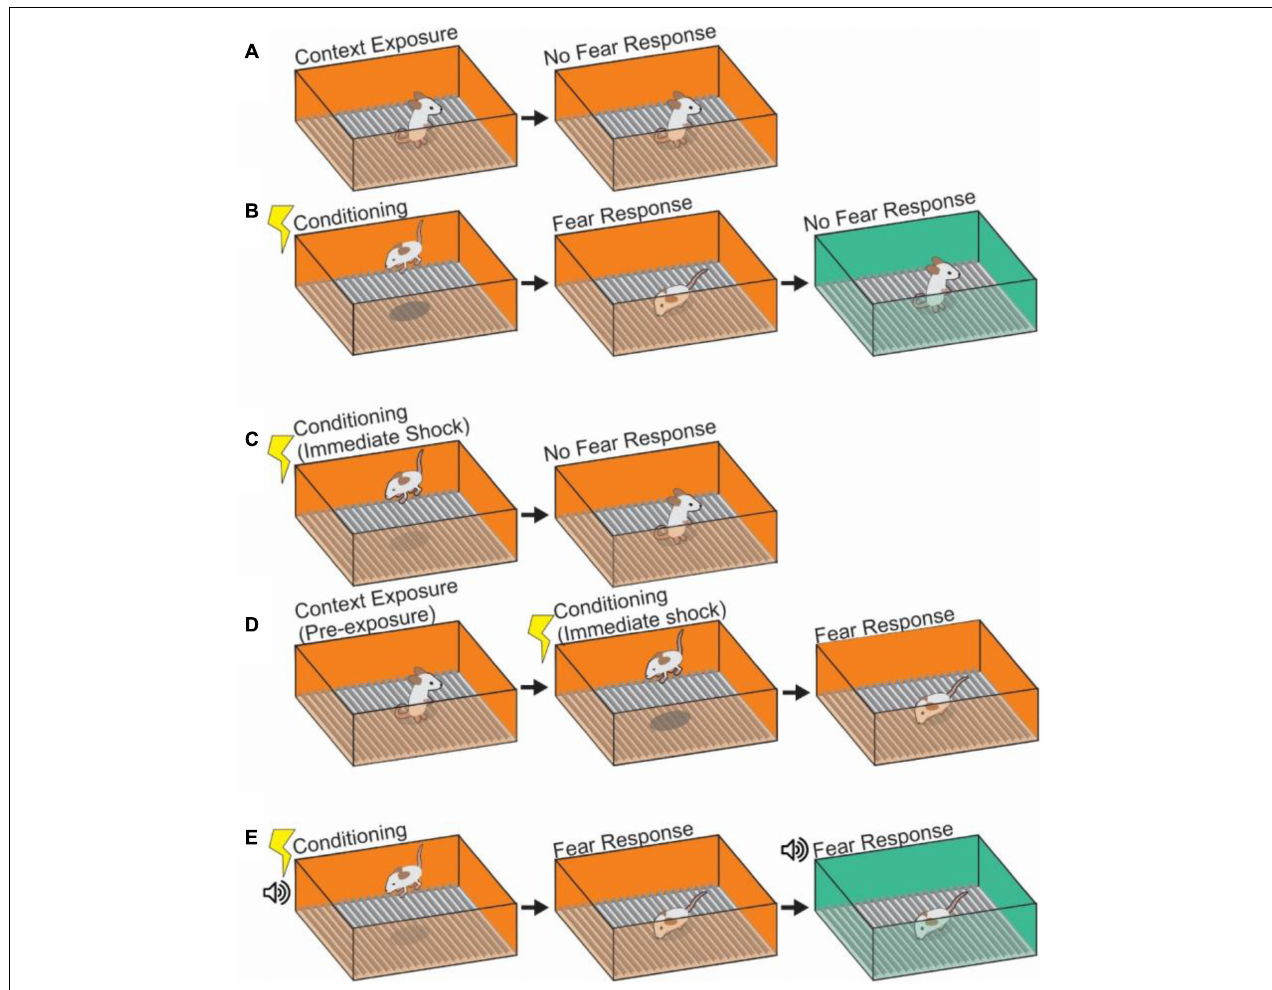
FIGURE 1 | Depictions of contextual learning. (A) The exposure of an animal to a context results in learning of that context. However, in the absence of any frightening stimulus, no fear response will occur to the neutral context. (B) Pairing of a shock with a contextual stimulus will cause fear responses upon return to that conditioned context, indicating a pairing of shock memory with memory of the contextual cues. Subsequent placement in a second neutral context will not provoke a fear response. (C) Depiction of an immediate shock protocol. A mouse which is shocked immediately upon being placed in a context and removed after will not pair shock learning with context as insufficient encoding of the context itself has occurred. (D) Pre-exposure to a context will alleviate the failure to learn after immediate shock. Animals pre-exposed to the same or similar context 24 h prior to immediate shock protocol will associate the shock with the context. (E) Auditory fear conditioning can be added to create a more complex contextual pairing in which the fear response is tied both to the visual context and the auditory context (the tone). The tone can cause a fear response in a neutral context and generalization of fear to that